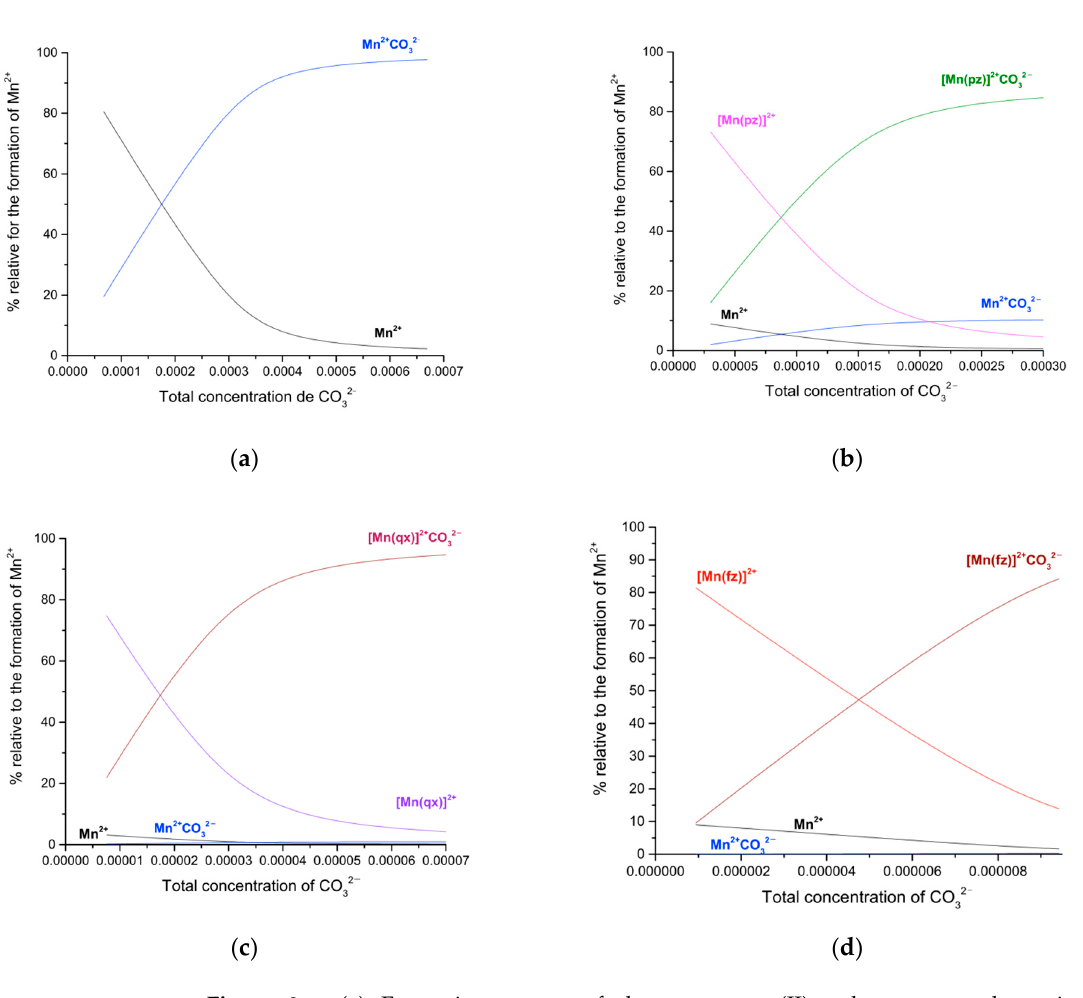
Figure 9. ( a ) Formation curves of the manganese(II)–carbonate complexes in methanol. [Mn] 2+ = 335 µ M and sodium carbonate range from 66.9 to 669 µ M. ( b ) Formation curves of the manganese(II)–pyrazine–carbonate complexes in methanol. [Mn] 2+ = 159 µ M, [pz] = 349 µ M and Sodium carbonate range from 30.2 to 302 µ M. ( c ) Formation curves of the manganese(II)–quinoxaline–carbonate complexes in methanol. [Mn] 2+ = 31.8 µ M, [qx] = 61.4 µ M and Sodium carbonate range from 7.54 to 75.4 µ M. ( d ) Formation curves of the manganese(II)–phenazine–carbonate complexes in methanol. [Mn] 2+ = 9.6 µ M, [fz] = 17.8 µ M and Sodium carbonate range from 0.9 to 9.4 µ M. Table 3. FIR and NIR spectral data for the complexes [Mn(pz)] 2+ , [Mn(qx)] 2+ , [Mn(fz)] 2+